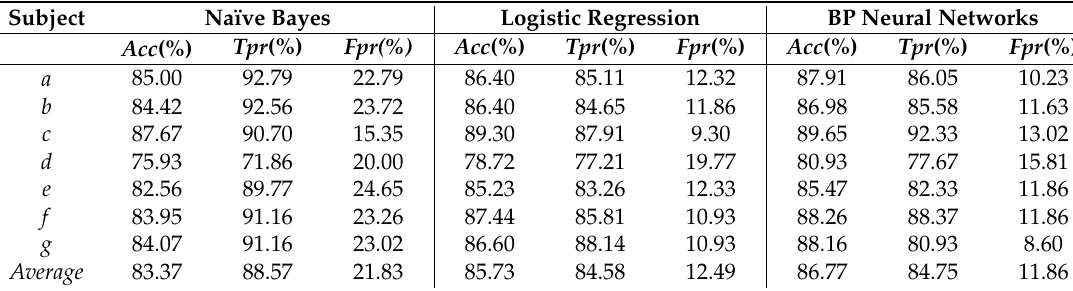
Table 5. The classification results based on the two-feature set (Fs2). BP: back